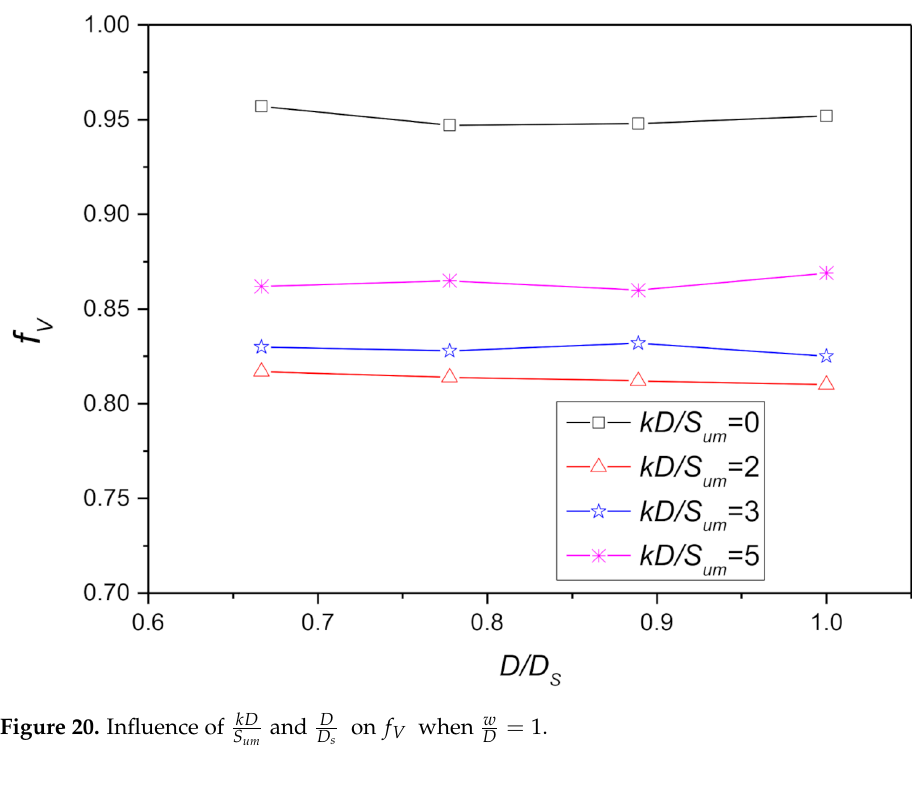
and D on f V when w D s S um